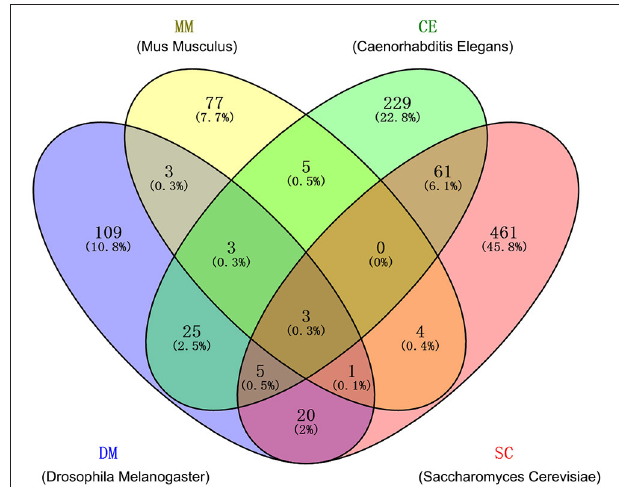
FIGURE 2 | Overlaps among four gene sets of human-orthologous aging-associated genes (AAGs) from 4 non-human organisms: Caenorhabditis elegans (CE), Drosophila melanogaster (DM), mus musculus (MM), and saccharomyces cerevisiae (SC). The detailed AAGs are provided in Table S1